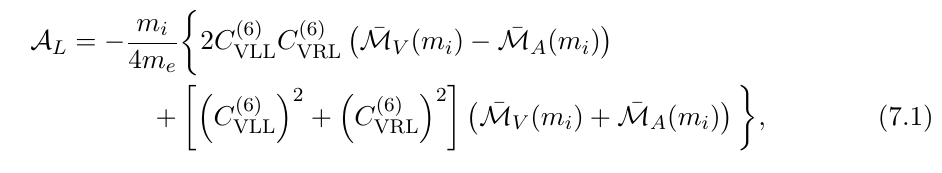
n -loop level give corrections (cid:24) ( m derivatives, (cid:24)